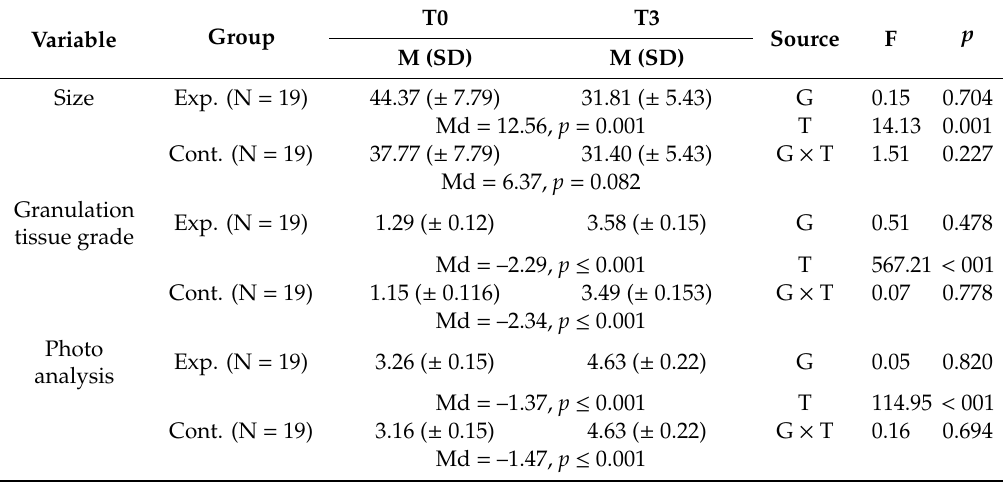
Table 4. Wound Evaluation; The results of changes in pressure wound size, granulation tissue grade, and photo analysis evaluated by experts before and after treatment were compared. Each evaluation showed a significant improvement in both groups (N =